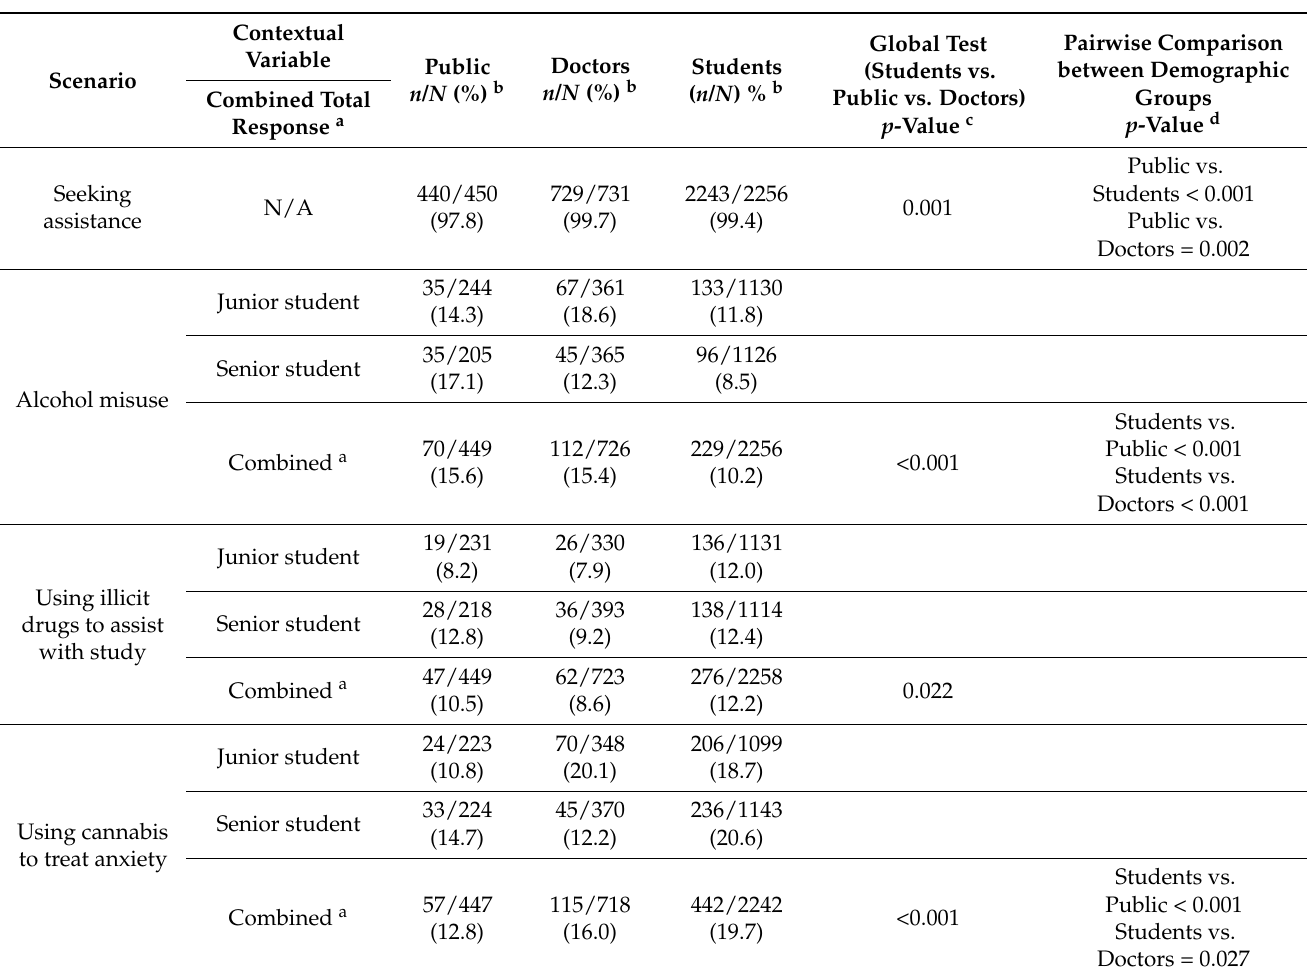
Table 3. Effect of Participants’ Demographic Backgrounds on their Responses to the PoMS Self-care Scenarios with Contextual Variables (Seniority of the Student Protagonist) Included and Combined Total